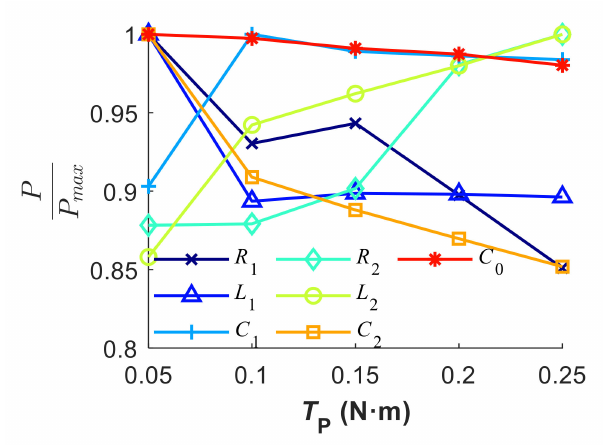
Figure 10. Drift of the equivalent parameters under di ff erent